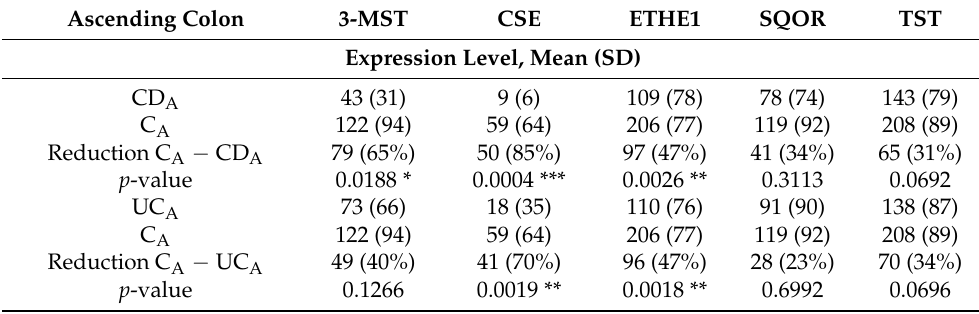
Table 7. Expression as mean with standard deviation (SD), absolute reduction and percentage as well as p -value of the ascending colon in adults with Crohn’s disease (CD A ) and adults with ulcerative colitis (UC A ) compared to age matched controls (C A ). Pediatric (P); adult (A); cystathionine- γ - lyase (CSE); 3-mercapto-sulfurtransferase (3-MST); ethylmalonic encephalopathy 1 protein (ETHE1); sulfide:quinone oxidoreductase (SQOR) and thiosulfate sulfurtransferase (TST). * = p -value < 0.05, ** = p -value < 0.01, *** = p -value <